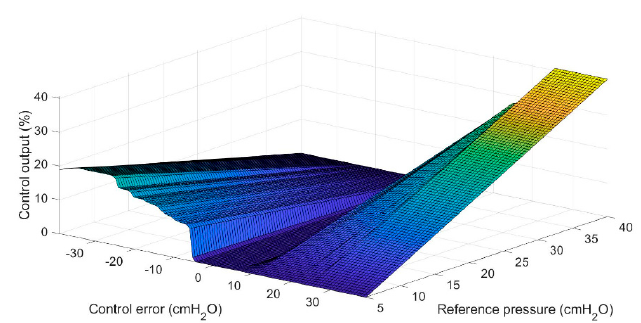
Figure 13. Influence of control error and reference pressure on final control output.